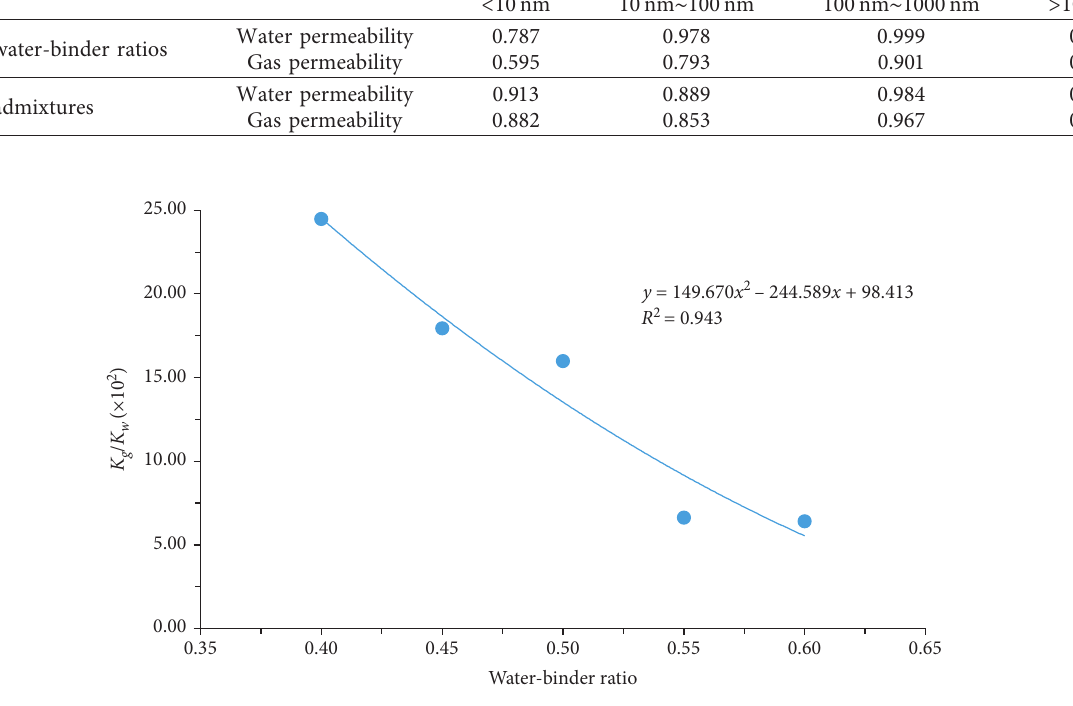
K ) versus water-binder ratio of concrete. g / w